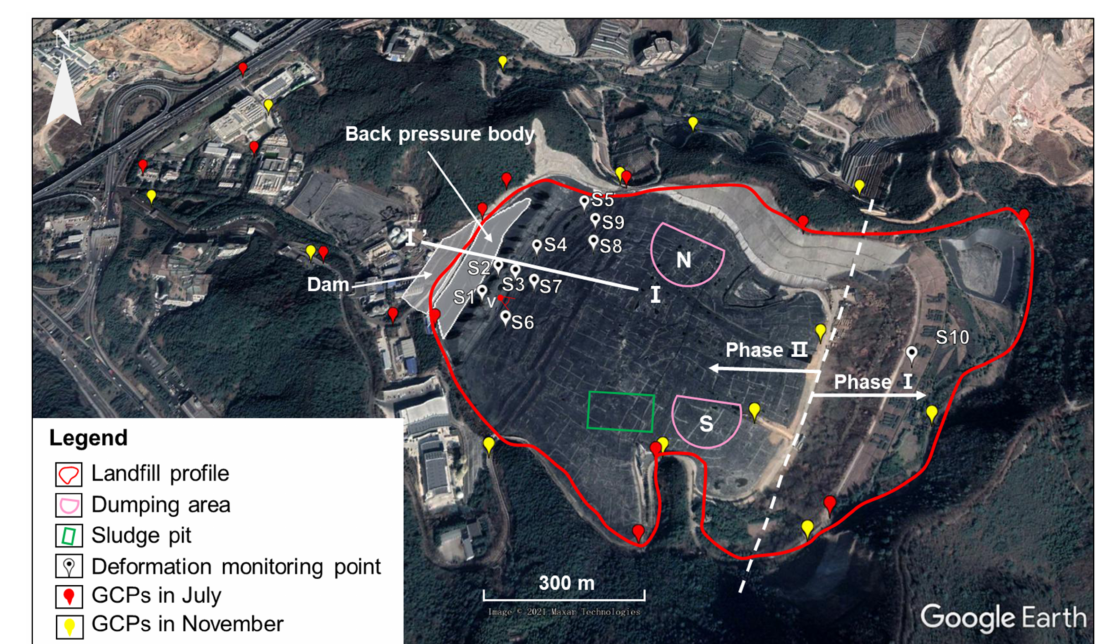
Figure 3. Aerial view of site conditions. The monitoring period for deformation monitoring points S1, S2, S3, S6, S7, and S10 was form March 2019 to July 2020, while that of monitoring points S4, S5, S8, and S9 was from July 2020 to November 2020. The white line I-I’ indicates the profile used for the instability probability analysis, while the white dashed line indicates the boundary of phase I and phase II projects. The red angle in point V shows the viewing direction during field investigation.